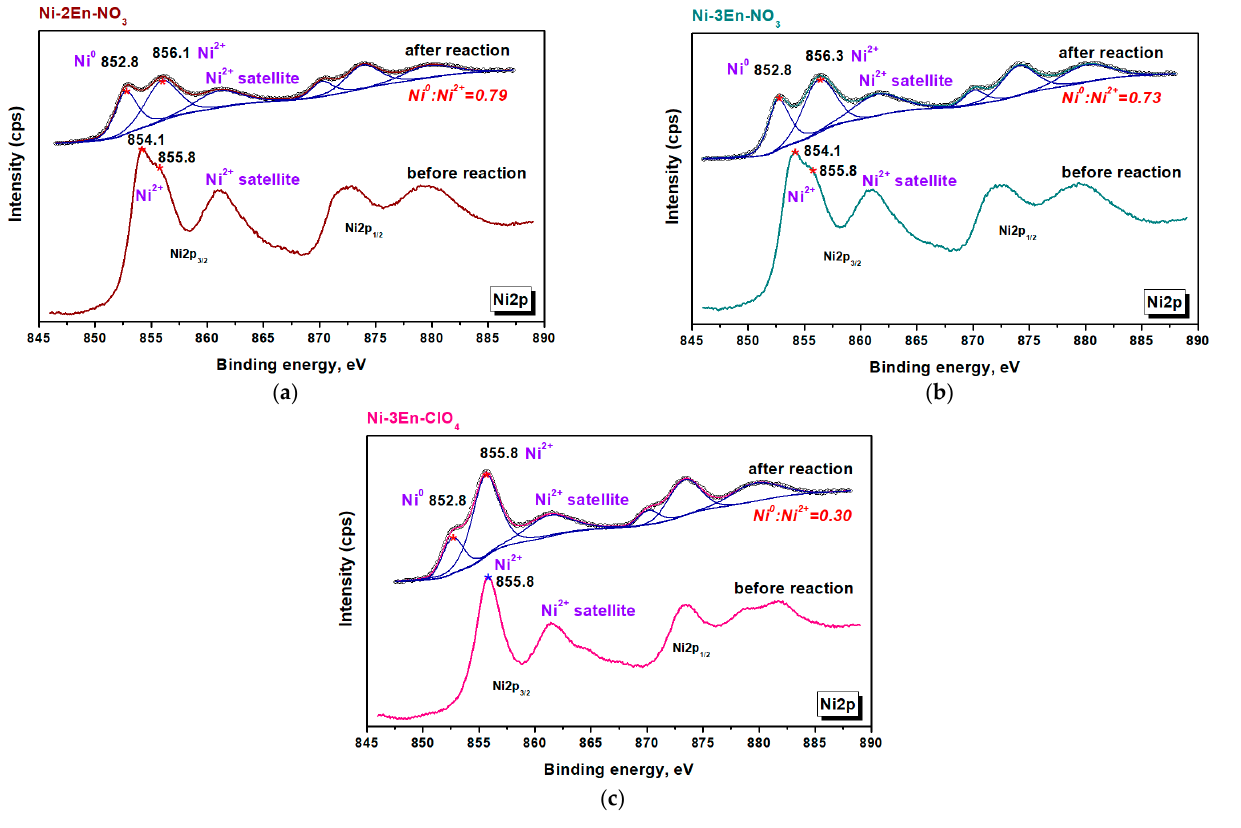
Figure 8. XPS spectra of Ni2p region for ( a ) Ni-2En-NO 3 , ( b ) Ni-3En-NO 3 and ( c ) Ni-3En-ClO 4 samples before and after activation at 450 °C in the reaction medium (H 2 :CO 2 :Ar = 16:4:80).